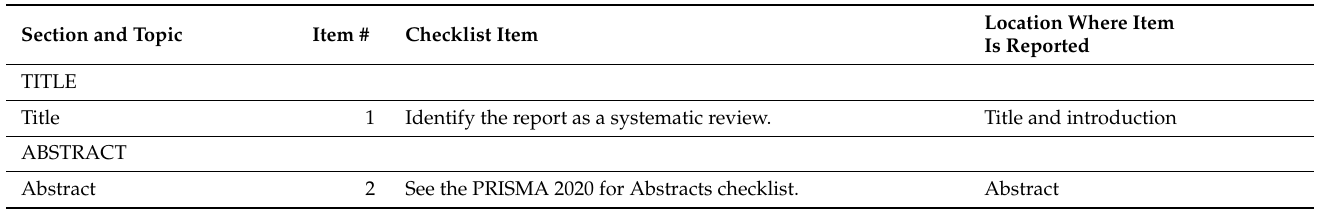
Table 2. Prisma checklist. n/a = not